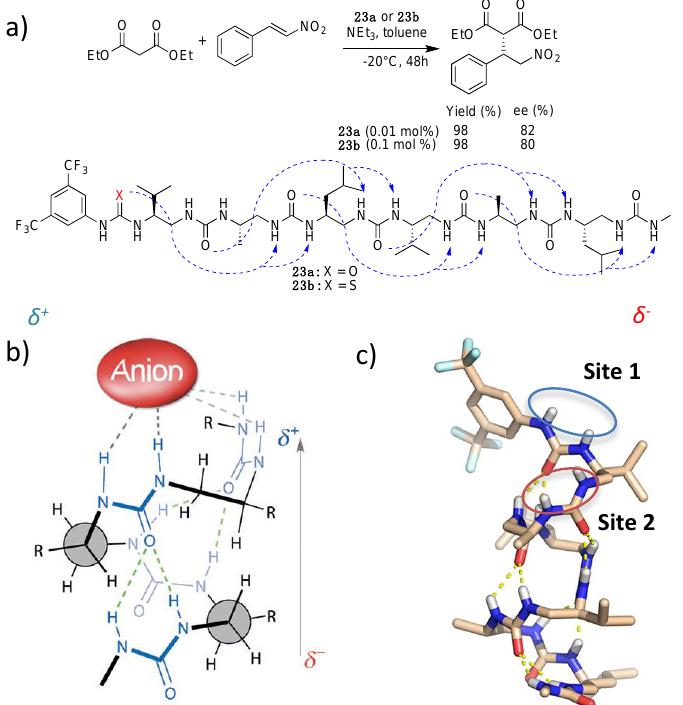
Figure 7. ( a ) Conjugate addition of diethylmalonate to nitroalkenes catalyzed by N,N′ -linked oligoureas 23a–b . The H-bond network (dashed curve) evidences the disponibility of the two ureas at the positive end of the oligourea. ( b ) Model for the binding of anion to N,N′ -linked oligoureas [110] . ( c ) X-ray crystal structure of 23a showing the accessibility of H-bond donor sites (Picture from [106] ).